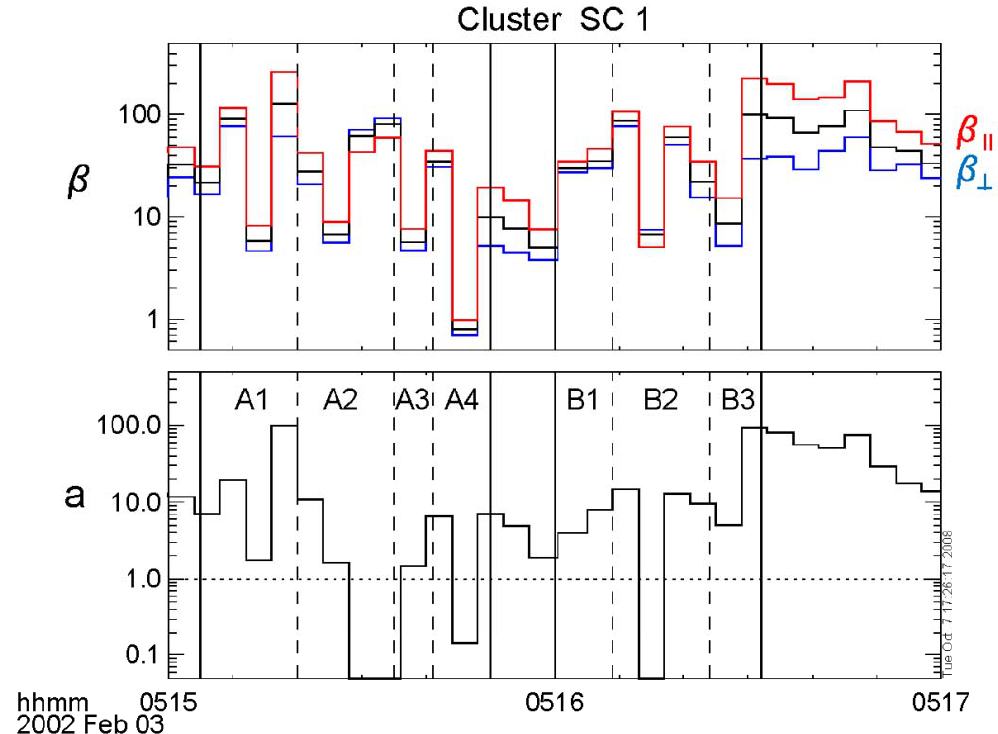
Fig. 5. Time variations of (1) Plasma β (black), β || (red), and β ⊥ (blue), as defined in the text. (2) Criterion for the firehose instability, a =(1 − T ⊥ / T || ) /( B 2 /4 π nT || )